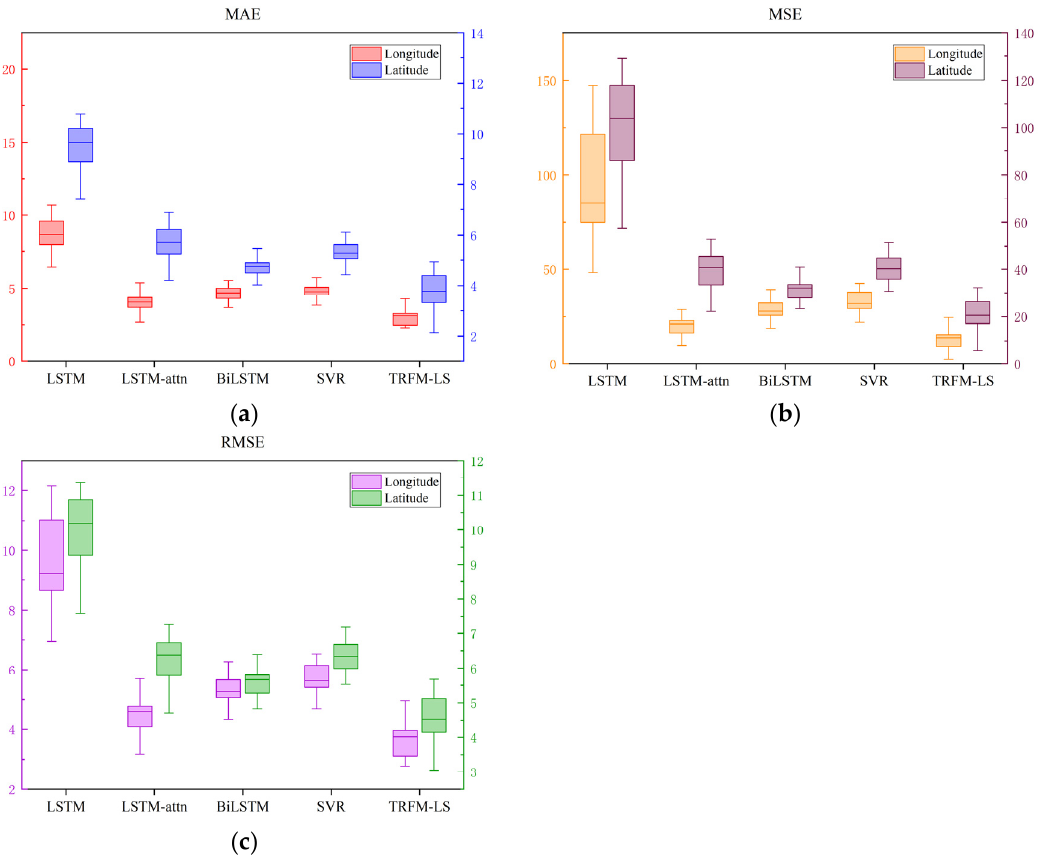
Figure 13. Metrics comparison of di ff erent methods: ( a ) Comparison of MAE predicted by di ff erent methods ( b ) Comparison of MSE predicted by di ff erent methods ( c ) Comparison of RMSE predicted by di ff erent methods.